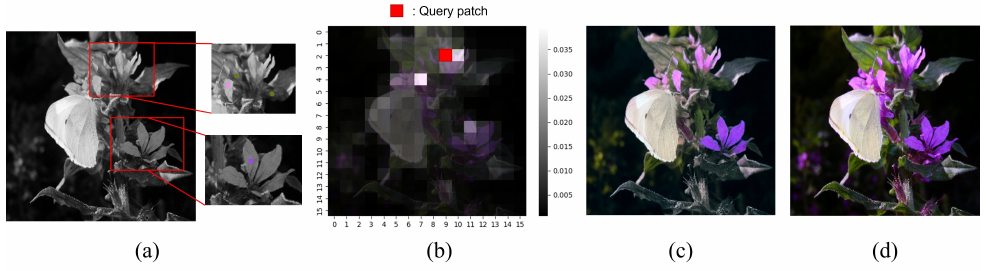
Figure 7. Visualization of the attention map in the bottleneck transformer layer. ( a ) Input (luminance and color hint). ( b ) Self-attention map in the bottleneck layer. ( c ) Visual result of HCoTnet. ( d ) Ground- truth color image.